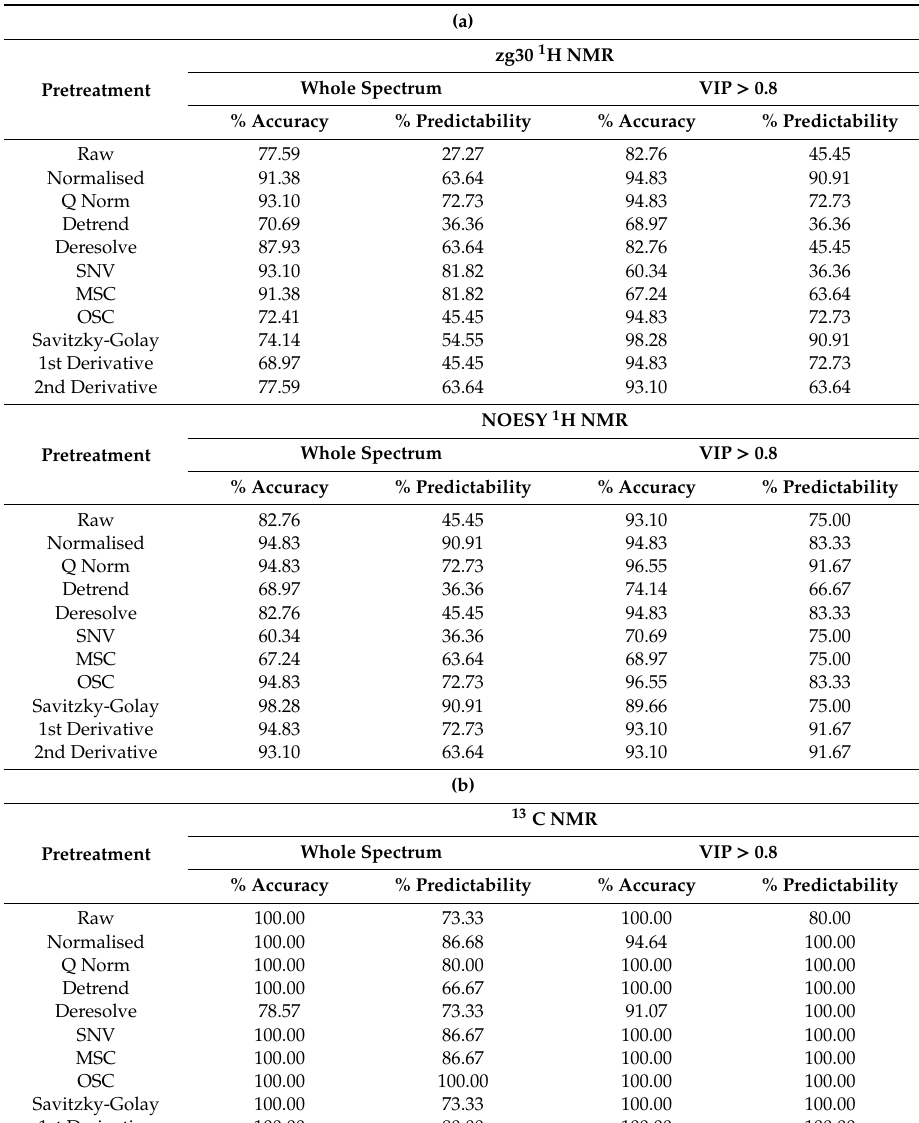
Table 3. The PLS-DA analysis on both the entire ( a ) 1 H NMR and ( b ) 13 C NMR spectra and selected variables having a VIP > 0.8 for the di ff erent spectral pretreatments. The results obtained on the training dataset are given in terms of % accuracy of correct classification whilst for the testing data set these are given in terms of % predictability of correct